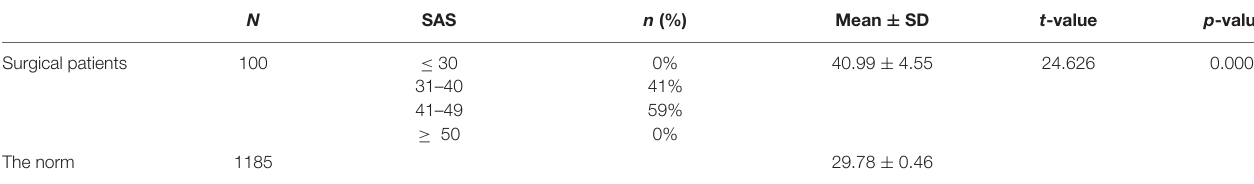
TABLE 2 | Sample’s level of preoperative anxiety and depression.